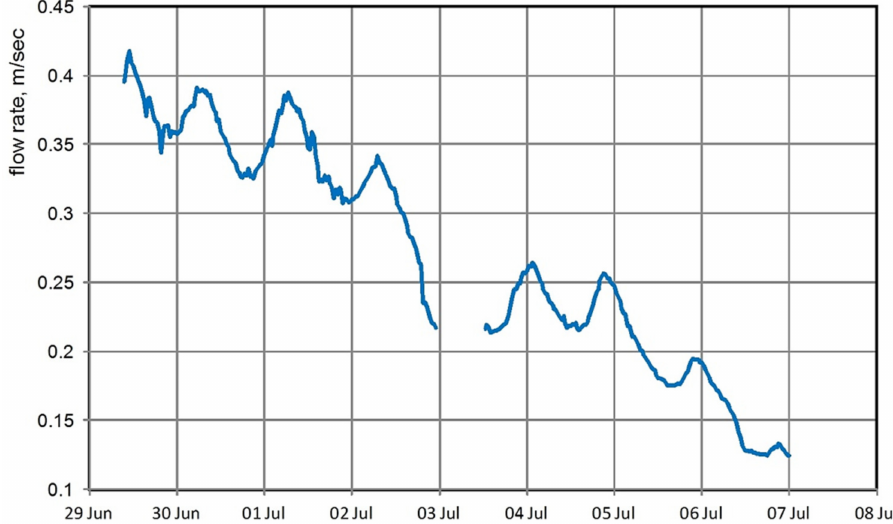
Figure 5. Daily cycles in flow rate dynamics in the Ugolnaya-Dionisiya